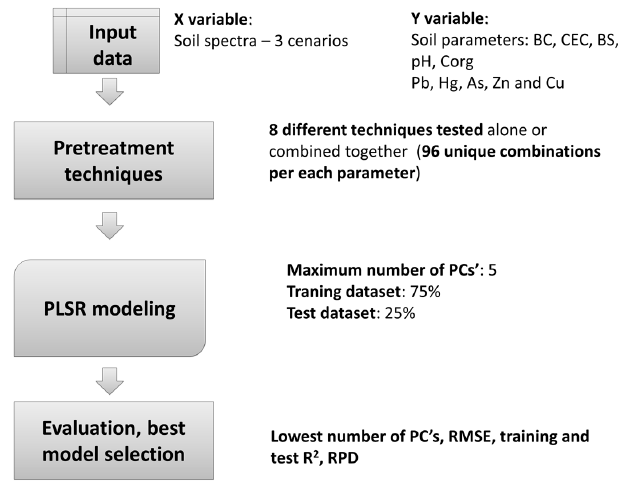
Figure 4. Simplified processing scheme (in total 2880 PLSR models were computed and assessed for 10 soil attributes using three spectral scenarios while testing eight selected pretreatment techniques).